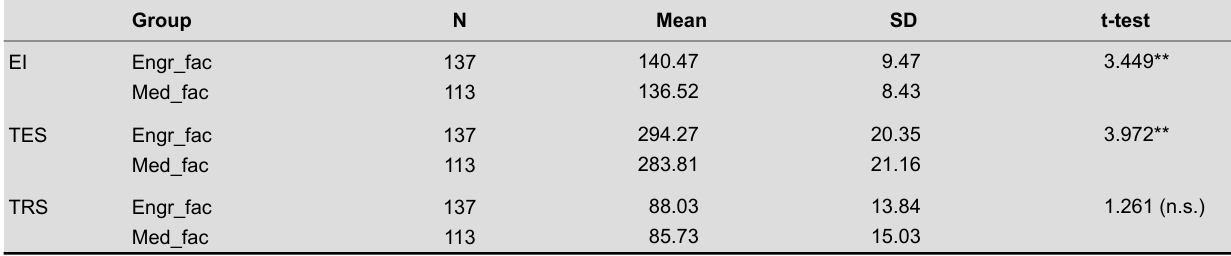
Difference in EI, TES and TRS of Engineering and Medical Faculty Members